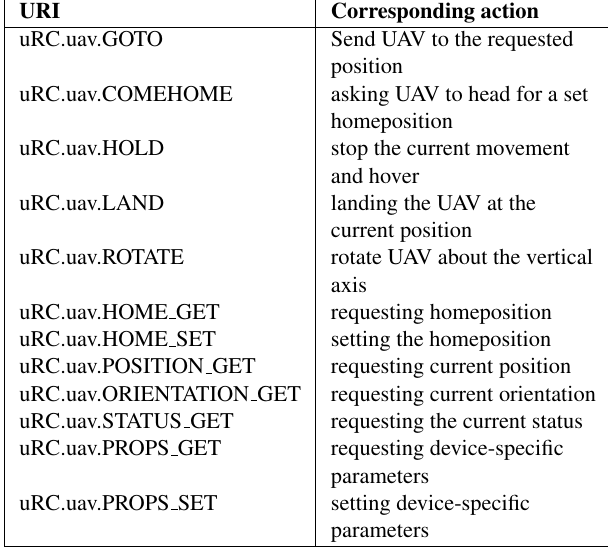
Table 1: Command-interfaces to control a UAV via